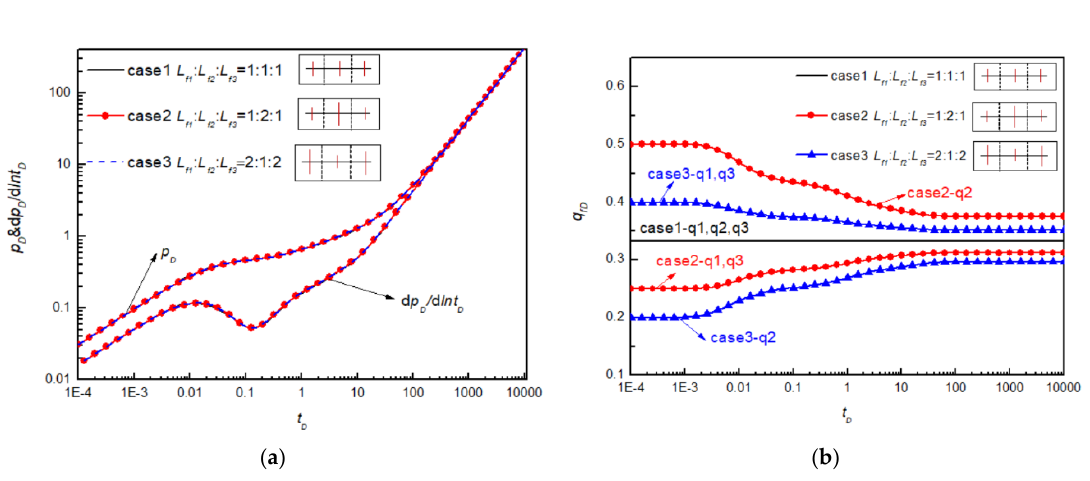
Figure 8. Pressure response and flux distribution of different crossflow ratio. ( a ) Pressure and pressure derivative; ( b ) Flux distribution of each hydraulic fracture.